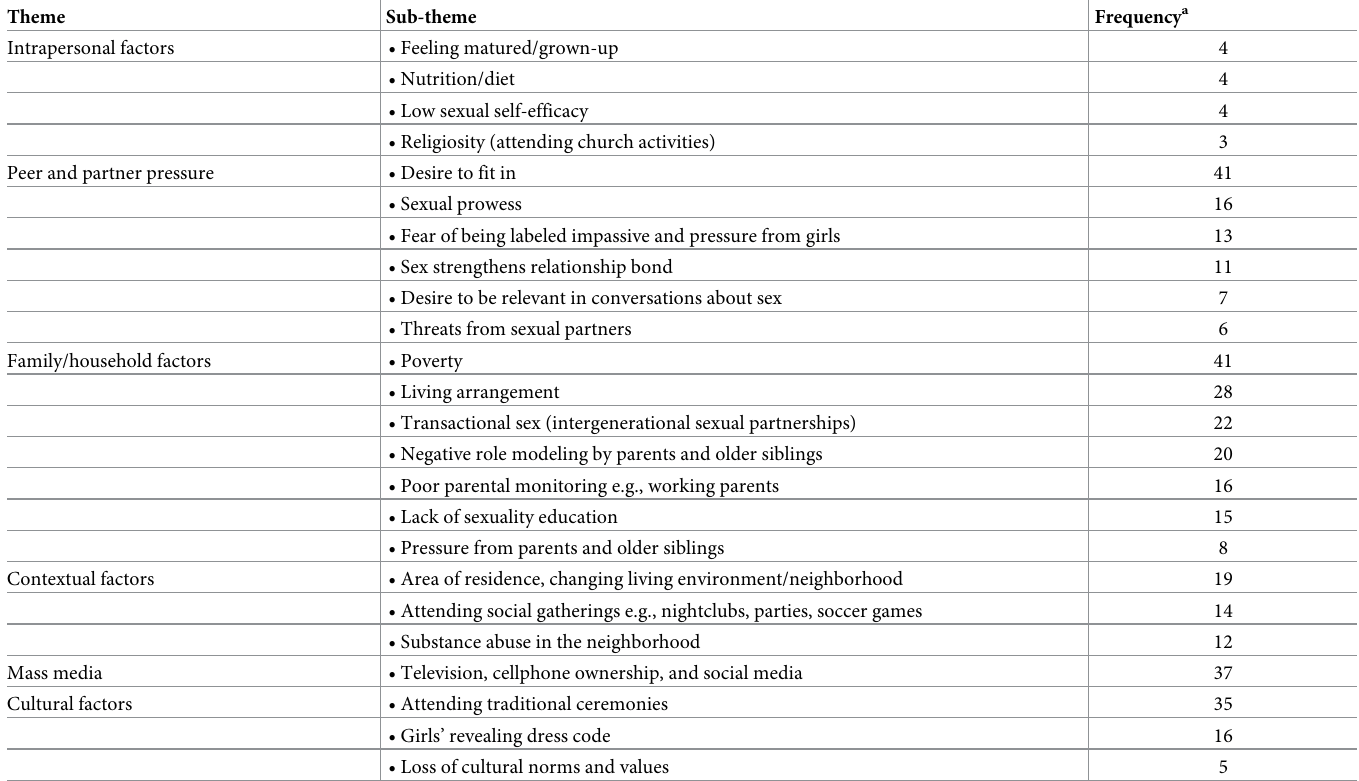
Table 2. Reasons for early sexual debut among in-school youth in